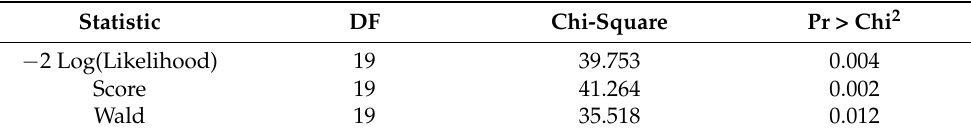
Table 1. Test of the null hypothesis H0: Y = 0 (variable: intraherd hierarchy status).